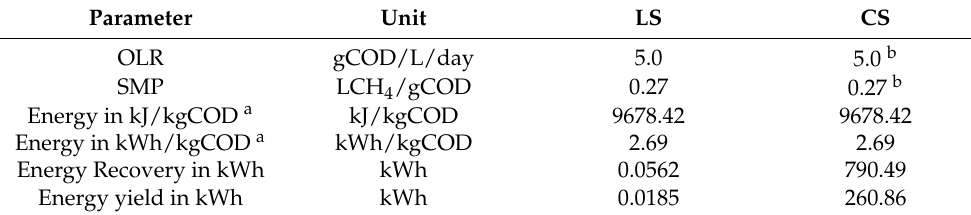
Table 3. Energy recovery from the treatment of CSWW in LS and